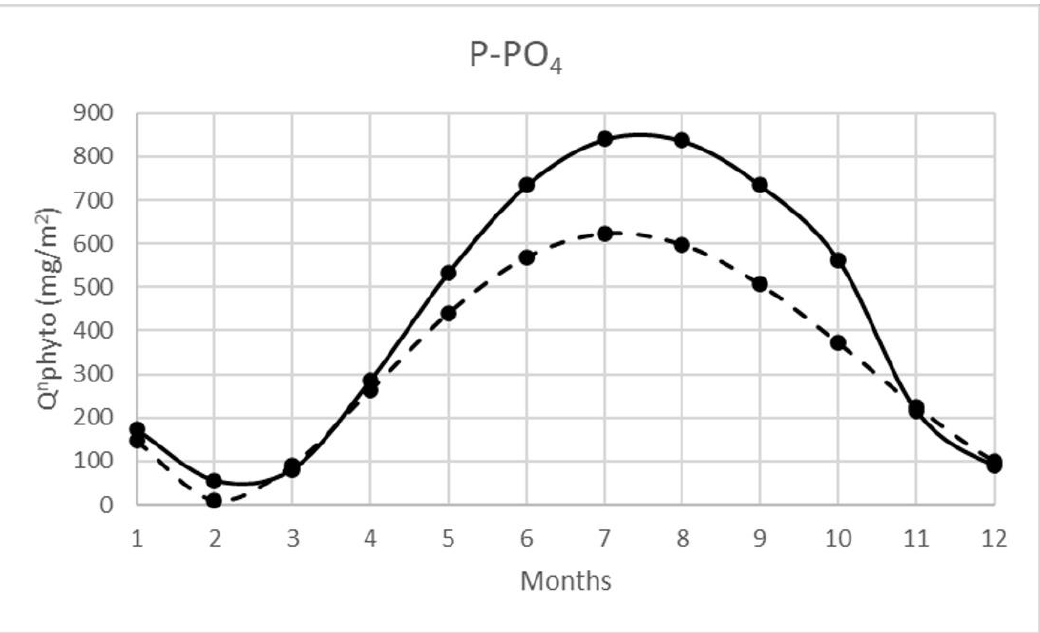
Figure 3. Example results assessment of the annual cycle nutrient consumption. Dotted line, exclud- ing remineralization (Equation (11)), solid — taking into account remineralization (Equations (12) remineralization (Equation (11)), solid—taking into account remineralization (Equations (12) and and (13)). In this figure, n can take values on the descending branch of the graph (usually 10 or 11). In this case n = 11 is November, then n – 1 — is October. ( Kj = (380 − 220)/380 = 0.42).